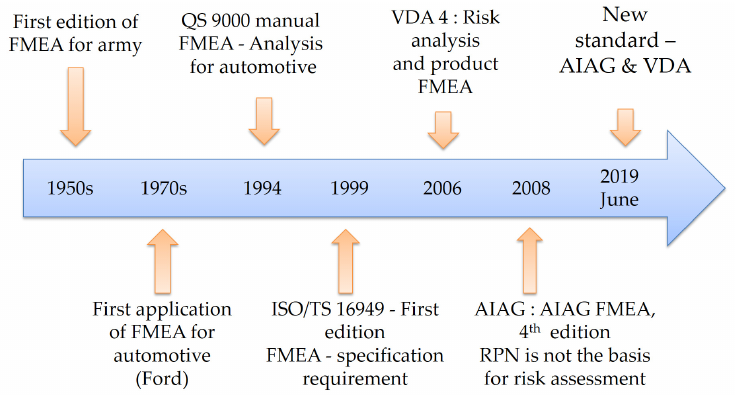
Figure 1. Evolution of the approach to FMEA. Data source: Dariusz et al . [21]